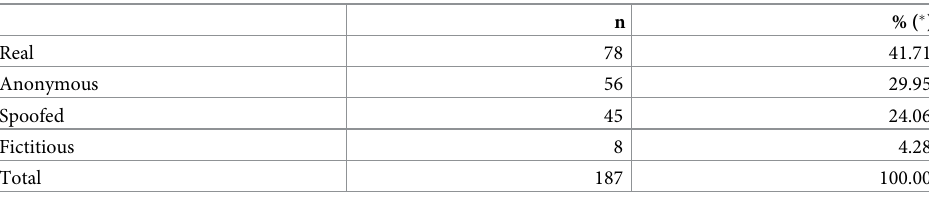
Table 11. Types of